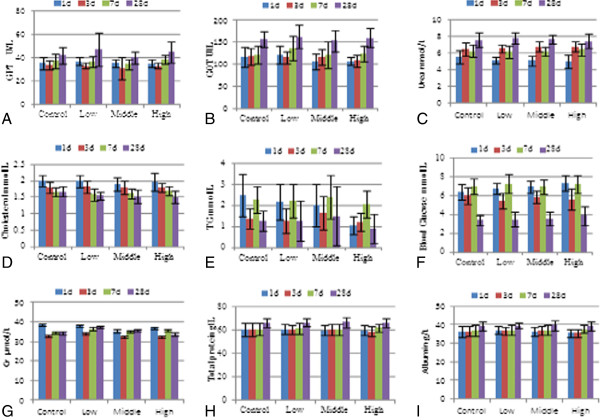
Changes of the blood biochemical data of rats treated with C-dots. The rats were treated with C-dots at doses of 0.2, 2, and 20 mg/kg BW in 1, 3, 7, and 28 days. (A) GPT, (B) GOT, (C) urea, (D) cholesterol, (E) TG, (F) blood glucose, (G) Cr, (H) total protein, and (I) albumin.